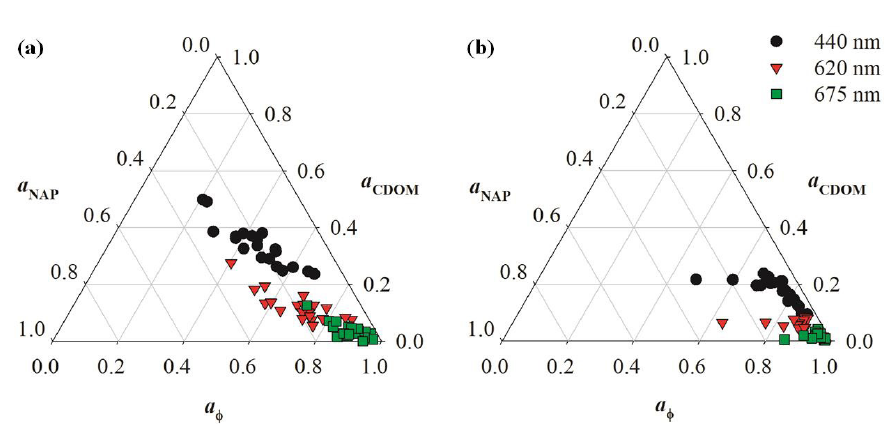
Figure 2. Ternary plots show the contribution of each optically significant constituent for a at 440, 620 and 665 nm collected in May (a) and October (b).